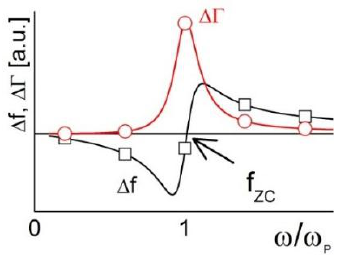
Figure 1. Shifts of frequency and bandwidth around a coupled resonance (23–25). f ZC is the frequency of zero crossing, which is similar to the particle resonance frequency.